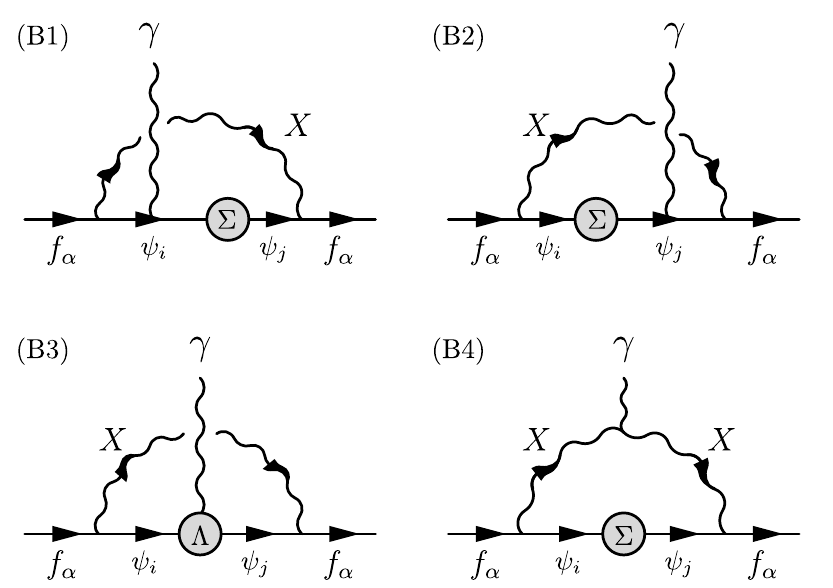
Figure 5 . Feynman diagrams potentially inducing non-zero EDMs of the fermion f α with the multi-fermions ψ and a vector boson X i